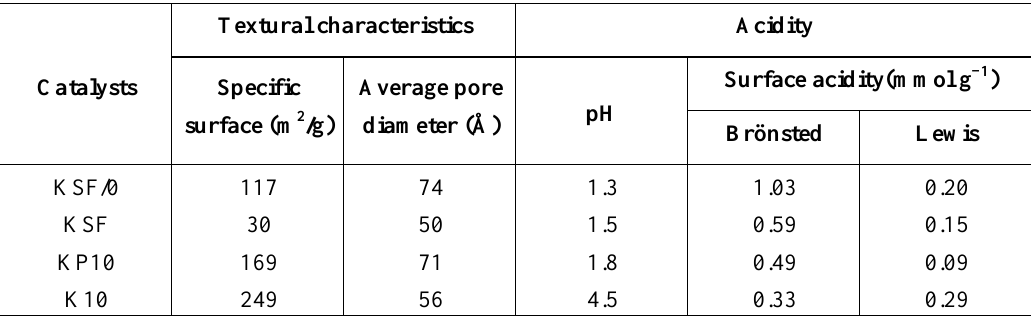
Table 1. Some characteristic data of the investigated catalysts [24].